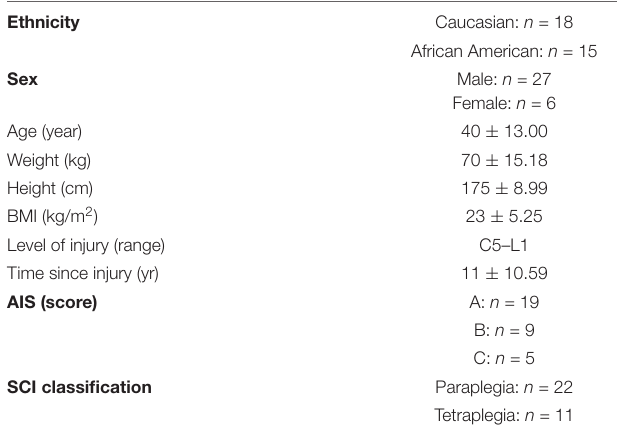
TABLE 1 | Baseline demographics and spinal cord injury characteristics for 33 participants.